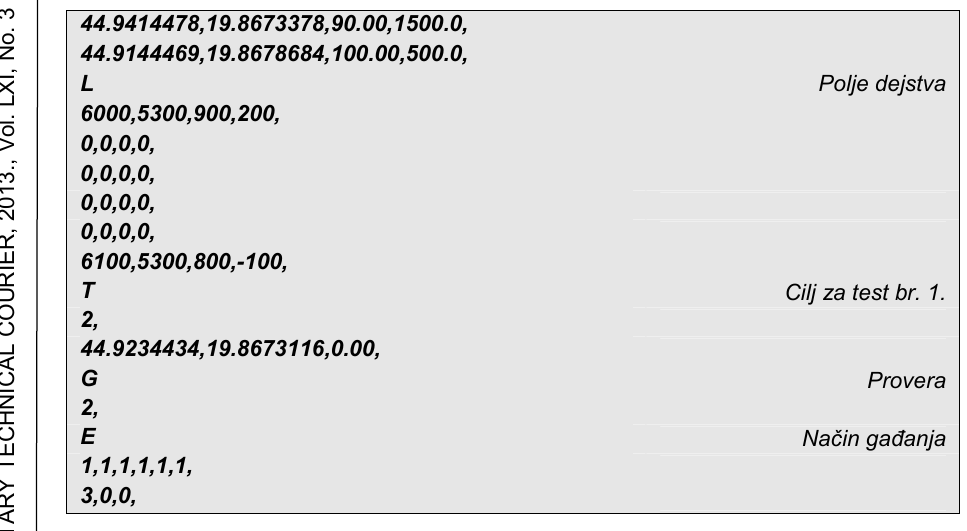
Figure 3 – Input database for the ballistic module